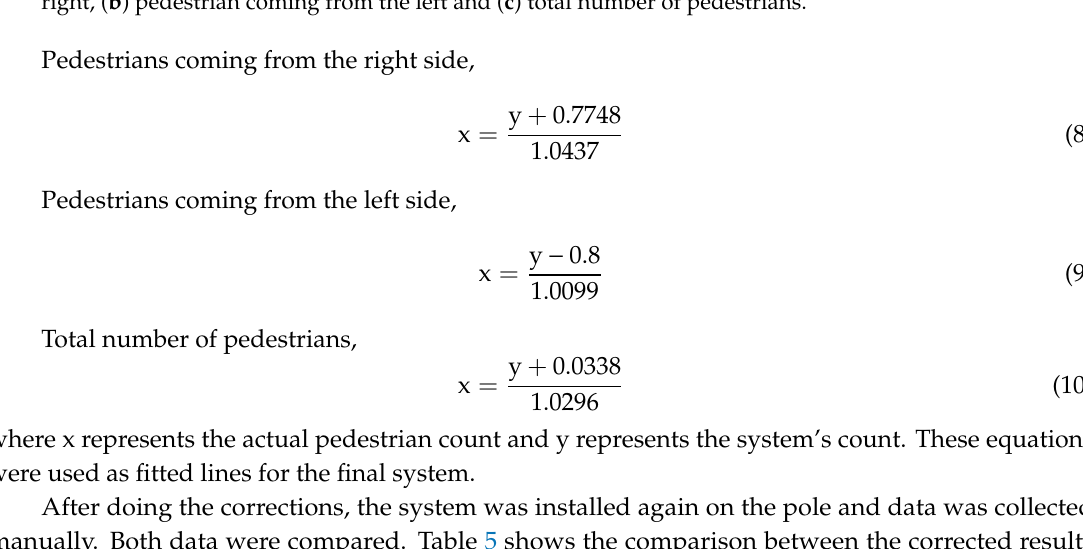
Figure 10. Comparison between the actual count and system count. ( a ) Pedestrian coming from the right, ( b ) pedestrian coming from the left and ( c ) total number of pedestrians. right, ( b ) pedestrian coming from the left and ( c ) total number of